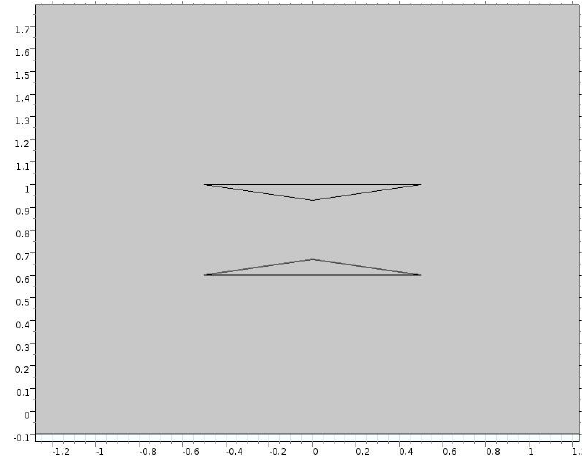
Figure 2. Cross-section of closed wind turbine housing